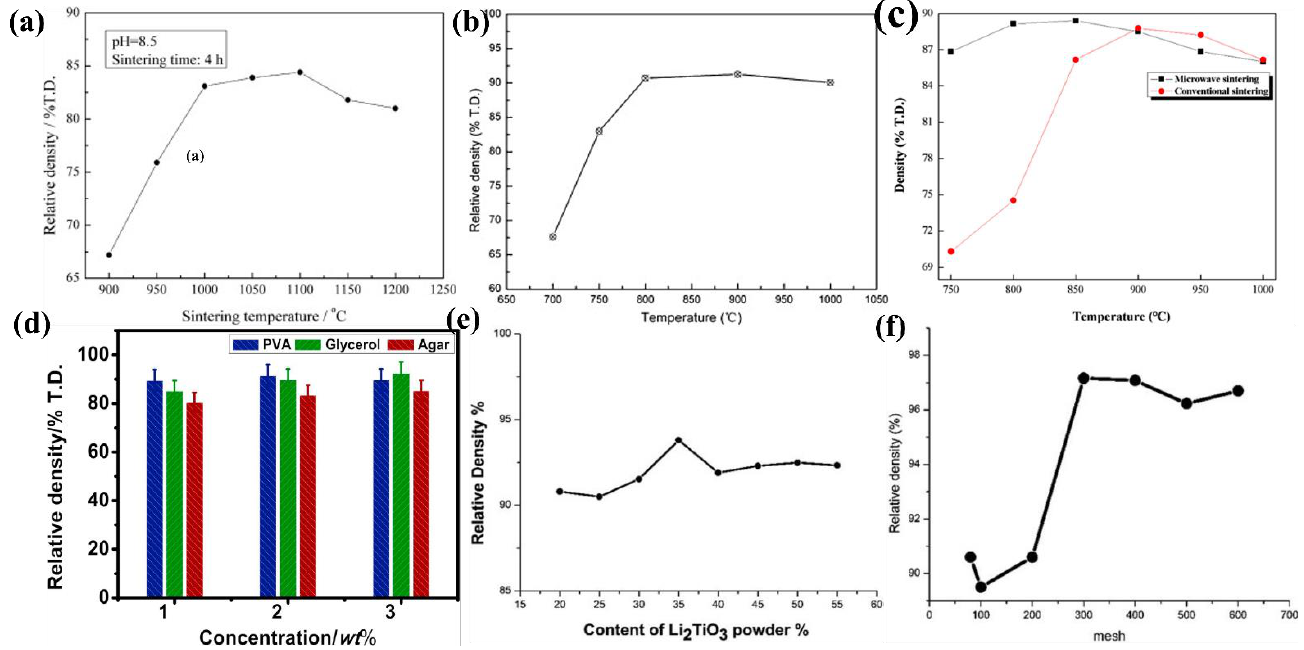
Figure 3. ( a ) Variation curve of pebble density with sintering temperature. Reprinted with permission from Ref. [45]. ( b ) Variation curve of relative density with sintering temperature. Reprinted with permission from ref. [62]. ( c ) Density of Li 2 TiO 3 pebbles sintered at different temperatures by microwave sintering (MS) and conventional sintering (CS). Reprinted with permission from ref. [57]. ( d ) Effects of different concentrations of additives on the density of Li 2 TiO 3 pebble. Reprinted with permission from ref. [78]. ( e ) Effect of slurry solid content on the density of Li 2 TiO 3 pebble. ( f ) Relationship between Li 2 TiO 3 powder particle size and Li 2 TiO 3 pebble density. Reprinted with permission from ref. [11]